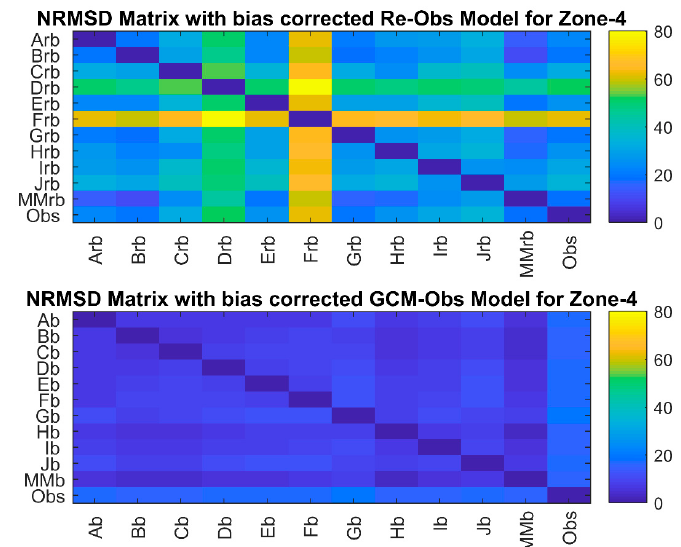
Figure 25. NRMSD matrix for downscaled precipitation using Re-Obs and GCM-Obs models post bias correction. Notations are similar to in Figure 23.